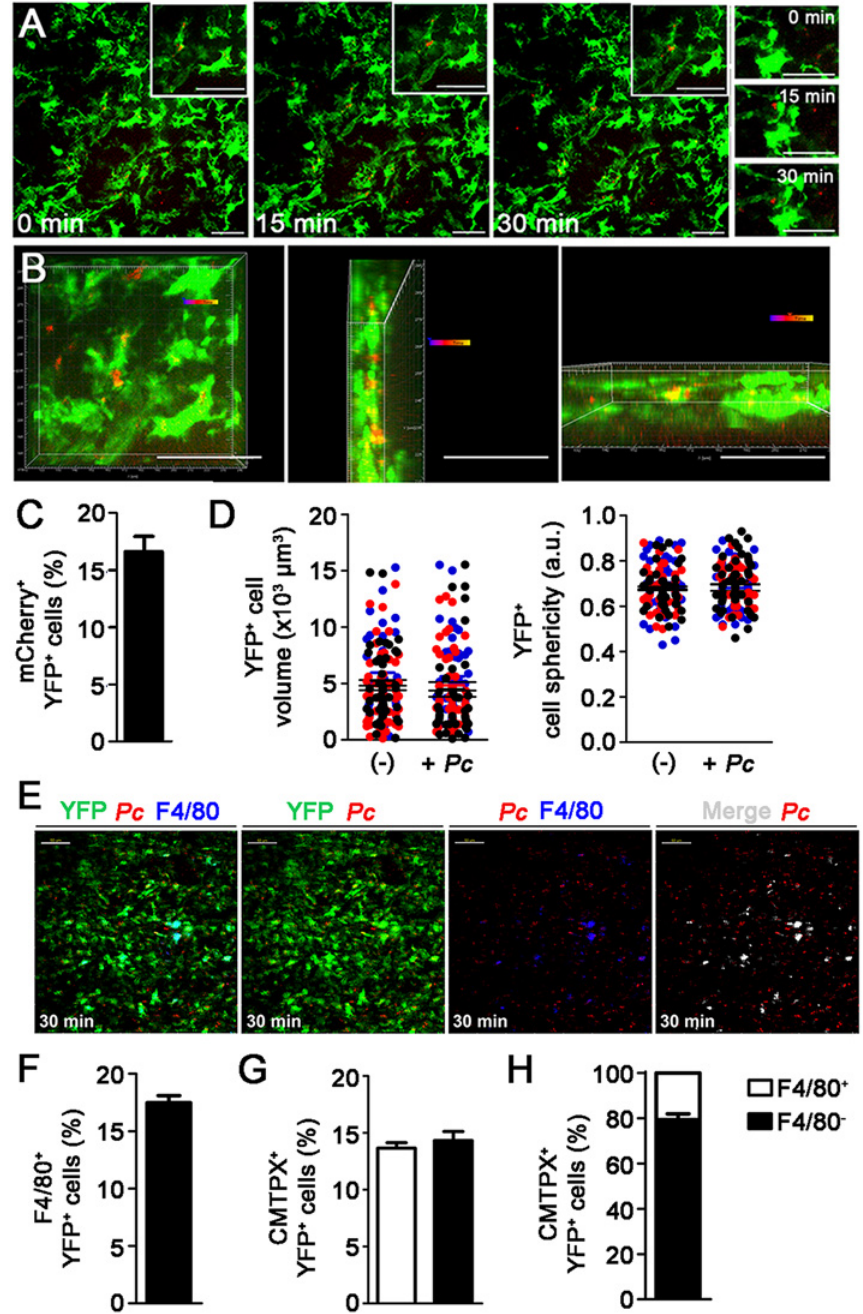
Figure 2. In vivo analysis of iRBC uptake by subcapsular RP DCs soon after Pc infection. (A-D) B6. CD11c-YFP mice were i.v. infected with 1 × 10 8 mature mCherry- Pc iRBCs. Spleens were analyzed by CIVM after 15 min and in non-infected controls. (A) Serial snapshots taken at 15 min p.i. (0 min) show the subcapsular RP. The upper panels show the amplification of a few cells co-expressing YFP (green) and mCherry (red). In the image on the right, a region showing contact between YFP + cells and mCherry- Pc iRBCs is magnified. (B) CIVM 3D animation reveals that YFP + cells contain mCherry- Pc iRBC remnants (yellow spots of merged mCherry/YFP-3D signal). (C) Percentage of mCherry + cells in the YFP + cell population is shown (mean ± SEM). (D) YFP + cell volume and sphericity are shown for na ï ve mice (-) and recently infected mice (+ Pc ). Black, red and blue dots are from three different experiments. Horizontal lines represent mean values and SEM. (E - H) B6.CD11c-YFP mice were i.v. infected with 1 × 10 8 mature CMTPX- Pc iRBCs. After 15